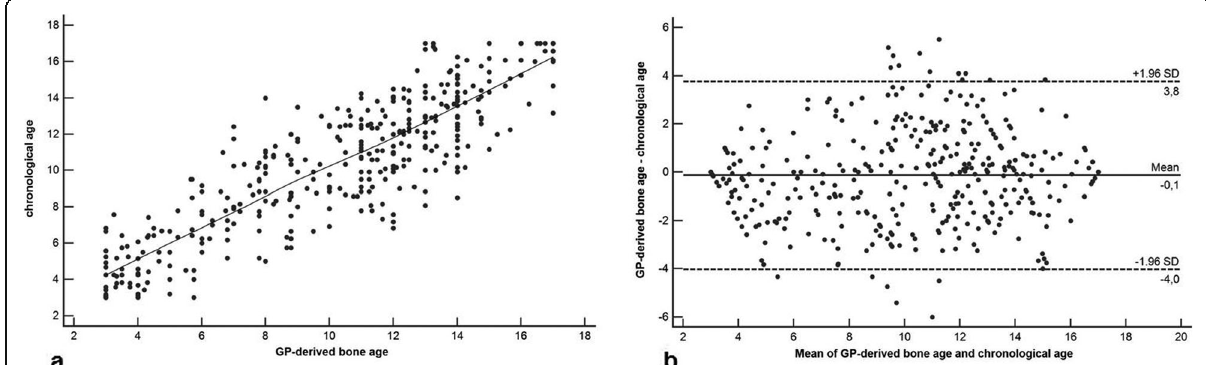
Fig. 6 Correlation and agreement analysis of BA values assessed by the three radiologists applying the Greulich-Pyle method and chronological age values. a Pearson product-moment correlation demonstrates significantly lower correlation with r = 0.842, 95% confidence interval (CI) 0.803 – 0.902, and r 2 = 0.760, 95% CI 0.725 – 0.804, compared to the correlation between values based on the software and chronological age values ( p < 0.001). b Bland-Altman plot also shows lower agreement between BA values assessed by the three radiologists applying the Greulich-Pyle method and chronological age values compared to the agreement between values based on the software and chronological age values ( p < 0.001). Values are given in years. BA Bone age, GP